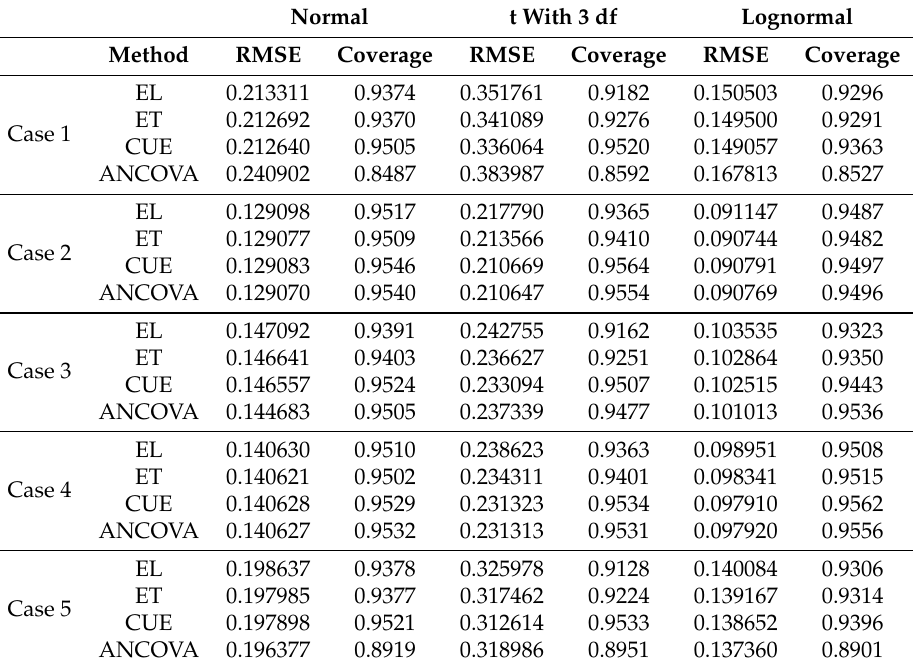
Table 6. Estimated root mean squared error and empirical coverage of nominal 95% confidence intervals (2 covariates).